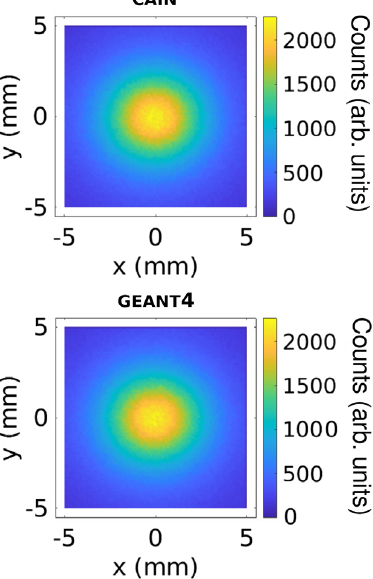
FIG. 7. Intensity spatial distribution at a distance from the IP of 10 m for the NewSUBARU photon beam simulated with CAIN and GEANT 4 . The axis scale was set to highlight the most significant part of the distribution.